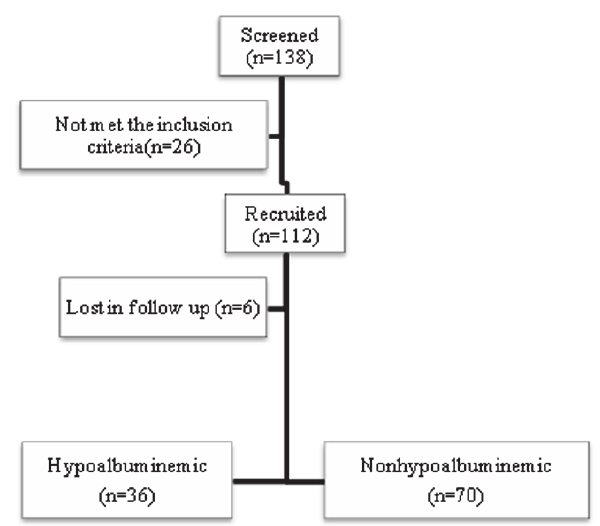
Figure 1: Work plan for the study The patients were classified into two groups (non- hypoalbuminemic and hypoalbuminemic) in relation to level of preoperative serum albumin (<35 mg/dl or >35mg/ dl). Patient’s demographic details, diagnosis, operative details and intraoperative outcomes were registered. All perioperative complications within 30 days of surgery were recorded. Complications were graded according to the